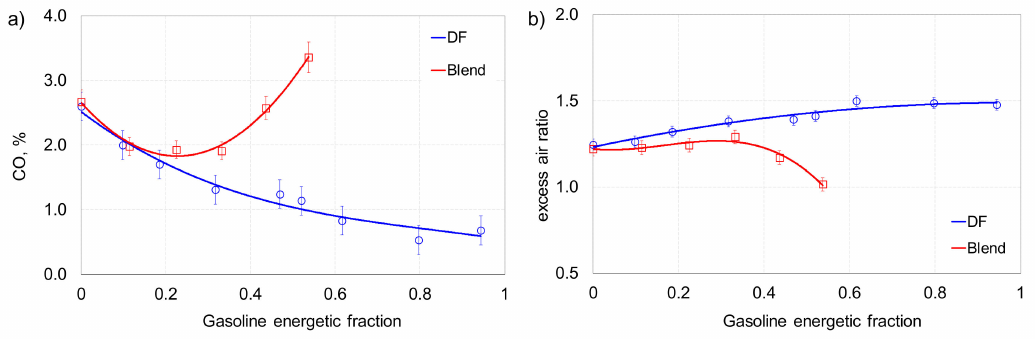
Figure 17. Emission of carbon monoxides (CO) ( a ) and excess air ratio ( b